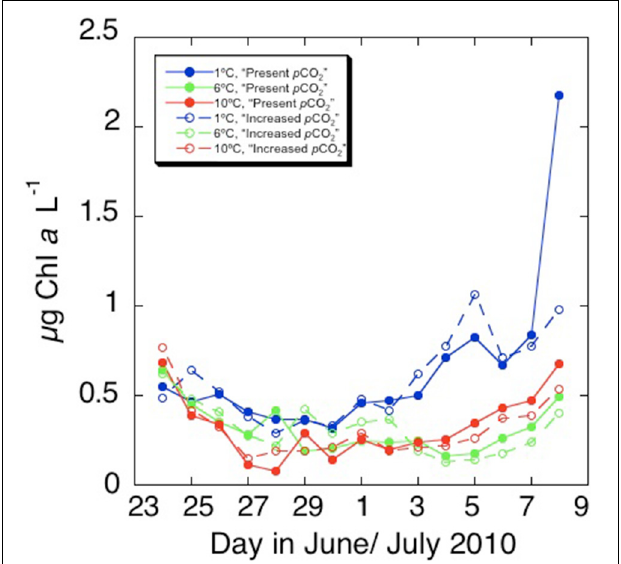
FIGURE 1 | Changes in the chlorophyll a concentration ( µ g L − 1 ) with time observed in the different treatments of increased temperature and p CO 2 in the arctic phytoplankton community.